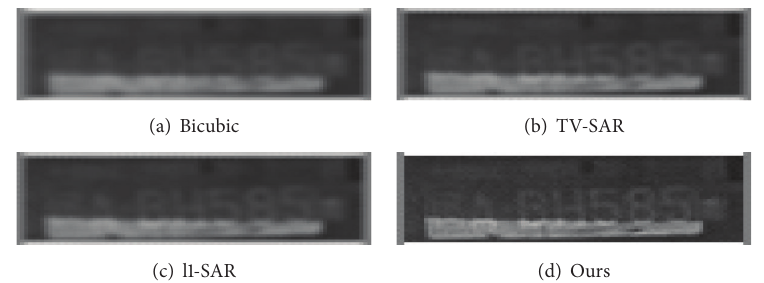
Figure 18: The reconstructed results for the LR license plates disturbed by black vehicle